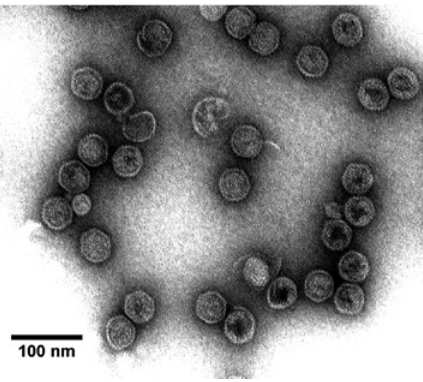
and pH for self-assembly and the formation of secondary structures at different ionic strengths, degradation, and stability in non-optimal conditions should be considered [107–110]. Considering these properties, the encapsula- tion of different enzymes such as alcohol dehydrogenase [111], glycosidase [100], and cytochrome P450 (CYP) [14, 15, 112] has been achieved (Figure 3). The design of syn- thetic “metabolomes” or multi-enzyme systems has also been proposed [113]. VLPs from different viruses have been synthesized including the non-enveloped icosahedral MVM (Minute virus of mice), PaV (Pariacoto virus), CCMV (Cowpea chlorotic mottle virus), NV (Norwalk virus), and bacteriophages U29, k, HK97, and P22. Likewise, they have also been produced from icosahedral capsids of enveloped viruses such as HBV (hepatitis B virus), HSV-1 (herpes simplex virus type 1), MLV (murine leukemia virus), HIV-1 (human immunodeficiency virus type 1), and influenza virus [114].